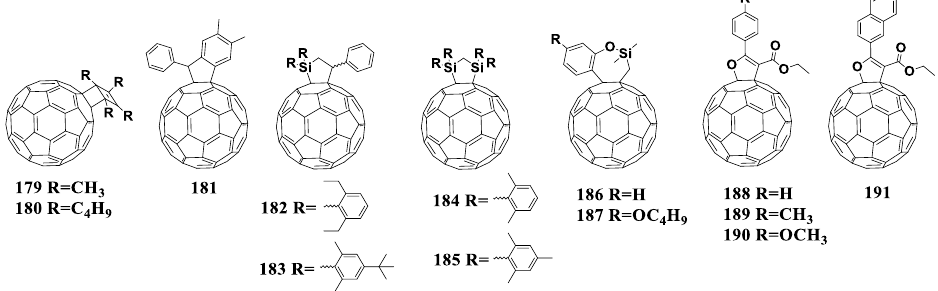
Figure 17. Molecular structures of the fullerene cycloadducts with reduced electron affinity.